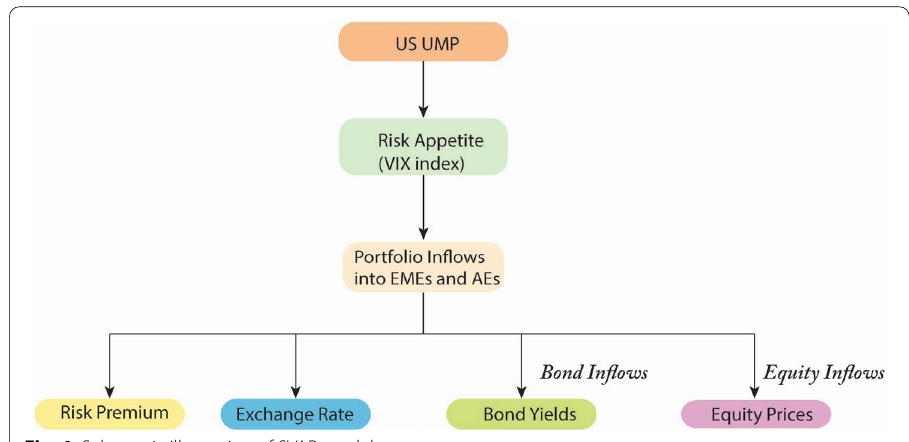
Fig. 4 Schematic illustration of SVAR model